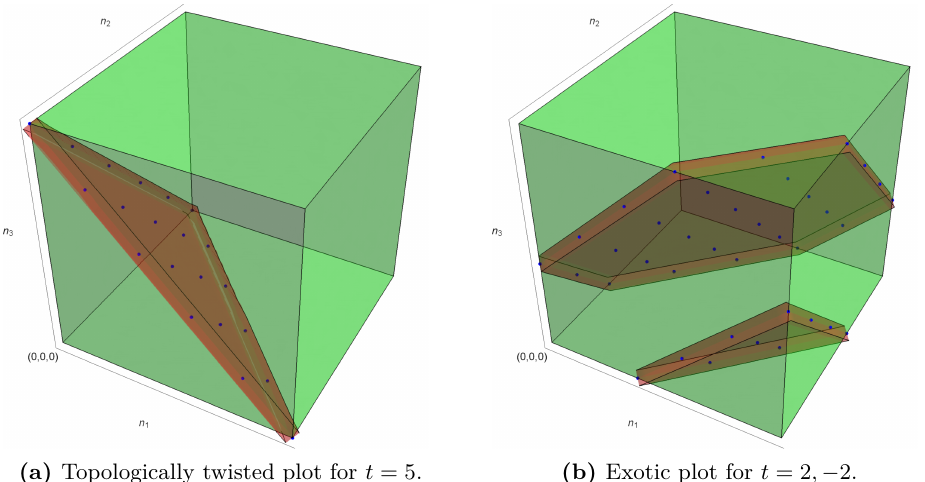
Figure 2 . We plot slices at different values of t = α ( m ) of the octant of R 3 spanned by positive ( n ) such that n = ∓ ( n + n ) . The orientation of the plane is related to the choice of 1 , n 2 , n 3 1 2 3 − t fiber used to reduce. Each slice determines the eigenvalues contributing at the corresponding flux sector of the perturbative partition function on CP 2